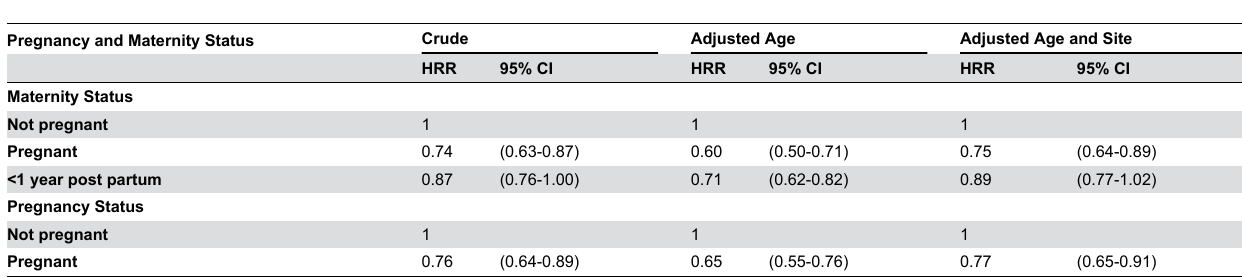
Table 6. Incident rate ratio comparing pregnancy status for all periods.